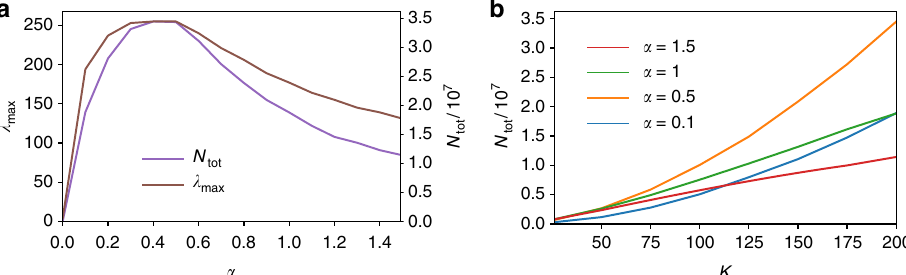
Fig. 6 Memory requirements of the TEMPO algorithm. We show both the total size of the fi nal MPS, N tot , and the maximum bond dimension, λ max , as a function of: a coupling α (at K = 200) and b memory cutoff K (for the various values of α